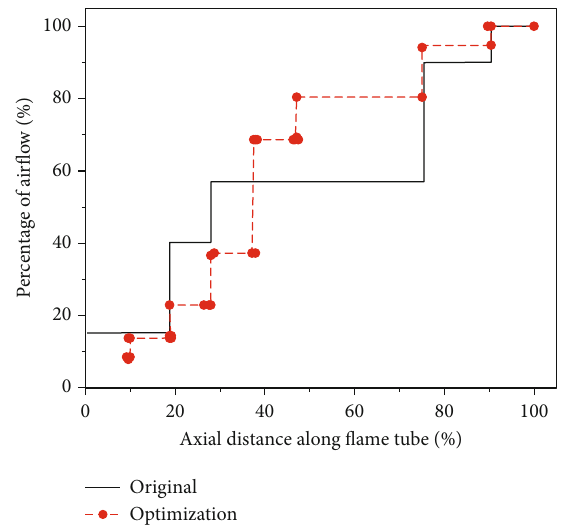
Figure 9: Air mass fl ow distribution comparison between the base case and optimized case along the axial direction.